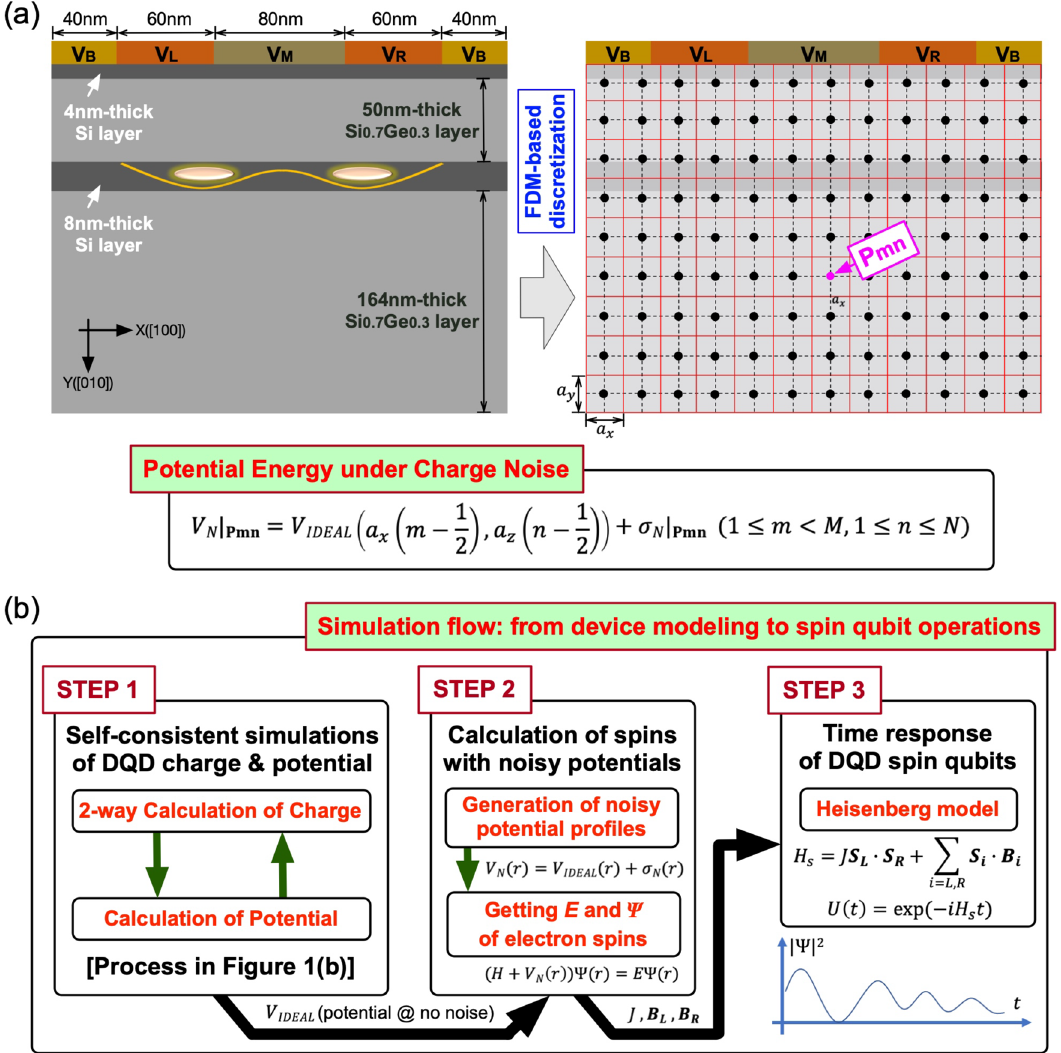
Figure 2. Incorporation of charge noise and steps for full-stack simulations covering from device modeling to qubit operations. ( a ) The effect of charge noise is incorporated into device simulations by disturbing the spatial distribution of potential energy under no noise ( V IDEAL ) with a random value that is generated per real-space grid in a silicon (Si) double quantum dot (DQD) structure under a zero-mean gaussian distribution of a standard deviation up to 5 µeV. ( b ) Starting with device modeling, our full-stack simulation can eventually predict 2-qubit operations of a Si DQD system with the following three steps: (1) device simulations that give bias-dependent energetic positions and wavefunctions of electron spin states under no charge noise, (2) disturbing the noise-free potential profile with charge noise, and (3) solving a time-dependent Schrödinger equation for the Heisenberg Hamiltonian of two neighbor spins that is constructed with results of device